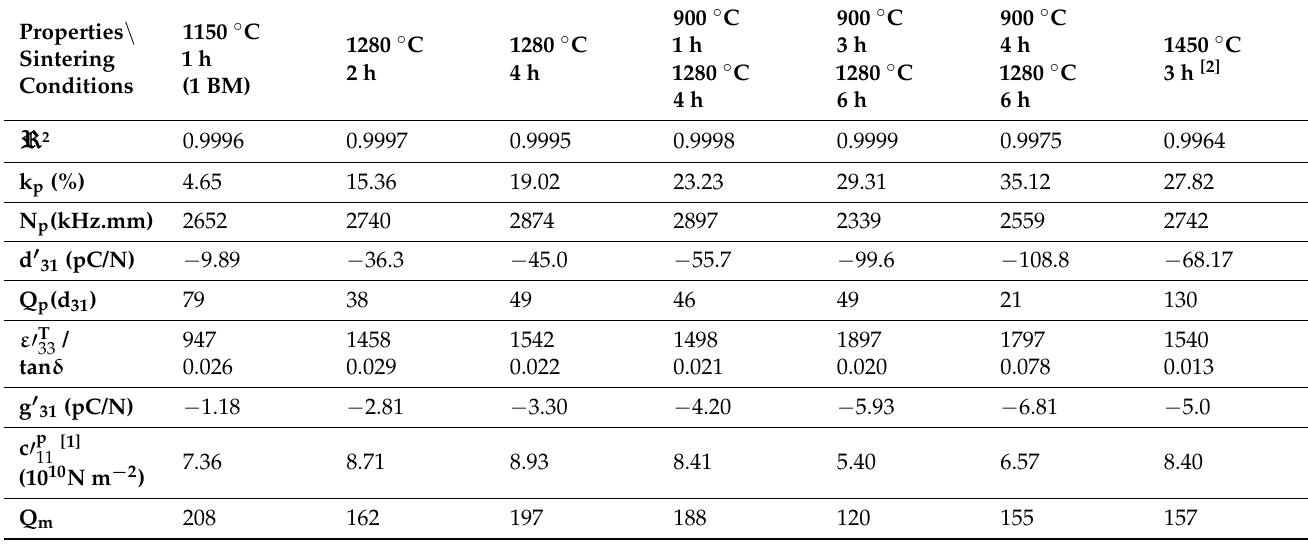
Table 4. Some relevant material coefficients obtained from the Radial mode of resonance of the sintered ceramics after synthesis at 700 °C under variable sintering method. The complex material coefficients (P = P ′ + iP ′′ ) are given as real part (P ′ ) and losses (piezoelectric and mechanical Q factor (P ′ /P ′′ ) and dielectric tan δ (P ′′ /P ′ )). The data for the sample calcined at 1350 °C are also shown for comparison.